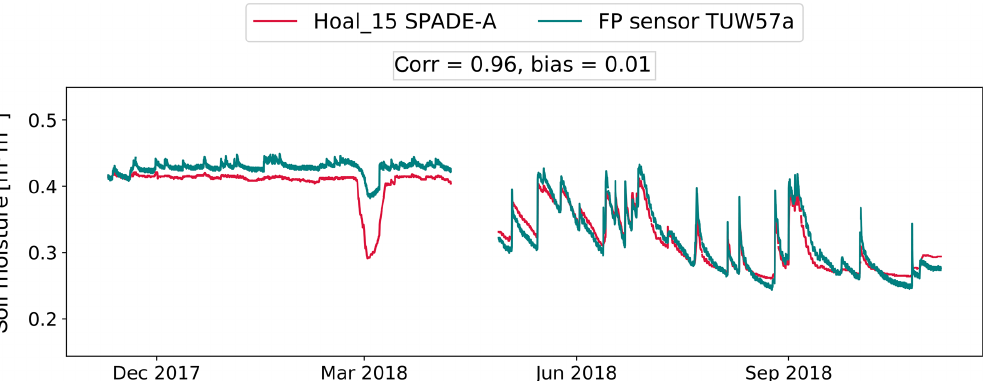
Figure A3. Soil moisture time series of horizontally installed FP sensor TUW57a and professional probe Hoal_15 at a depth of 0.05m, installed next to each other. The good agreement is underpinned by a high correlation value and low